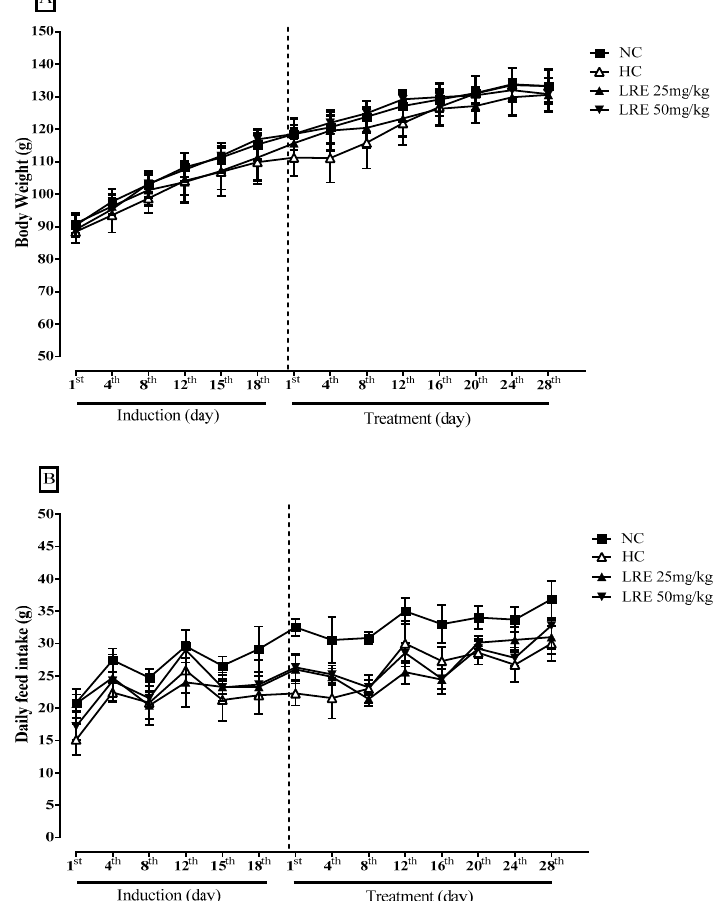
Figure 4. Body Weight (g) ( A ) and Feed Consumption ( B ) of hamsters submitted to experimentally induced dyslipidemia and treated with LRE. Results are expressed as mean ± SEM (standard error of the mean) of 7-9 animals/group.